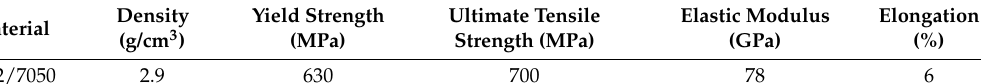
Table 2. Mechanical and physical properties of TiB 2 /7050 Al composite at 20 °C .